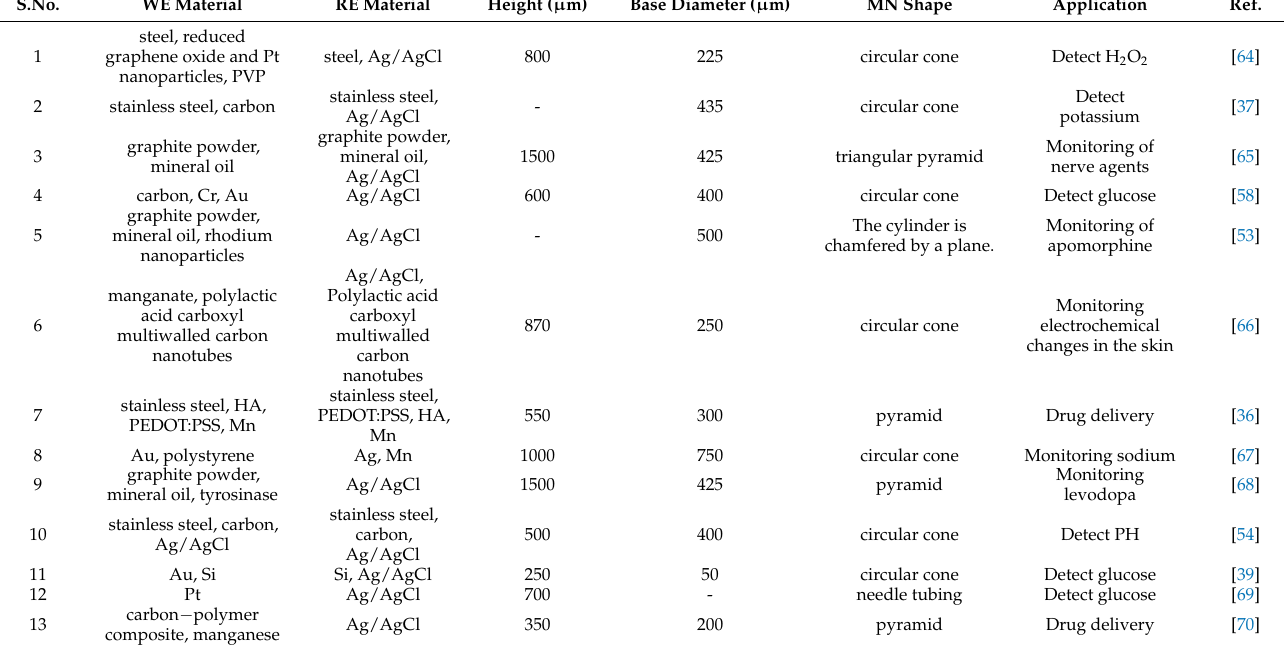
Table 1. Materials and shapes of microneedles and their applications in the field of